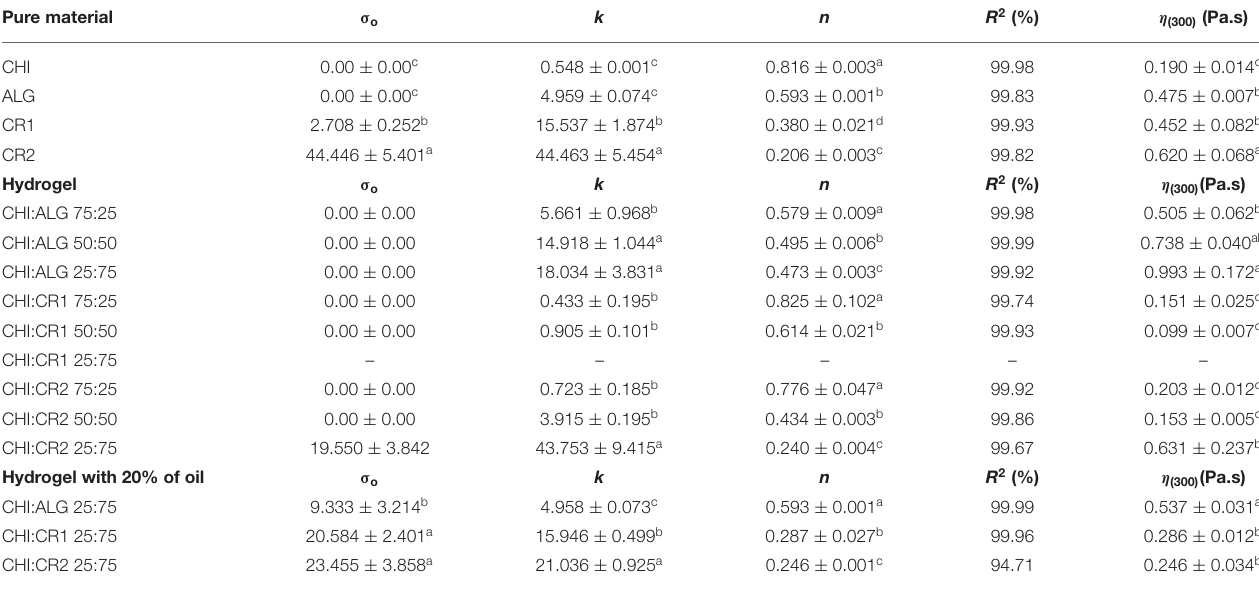
TABLE 1 | Rheological parameters (HB model) and apparent viscosity at a shear rate of 300 s − 1 ( η (300) ) of pure materials (2% w/v), complex hydrogels (CHI:ALG, CHI:CR1, and CHI:CR2) at different polymer ratios (75:25, 50:50, and 25:75), and hydrogels (CHI:ALG 25:75; CHI:CR1 25:75, and CHI:CR2 25:75) with 20% of canola oil. Pure material σ o k n R 2 (%) η (300) (Pa.s)